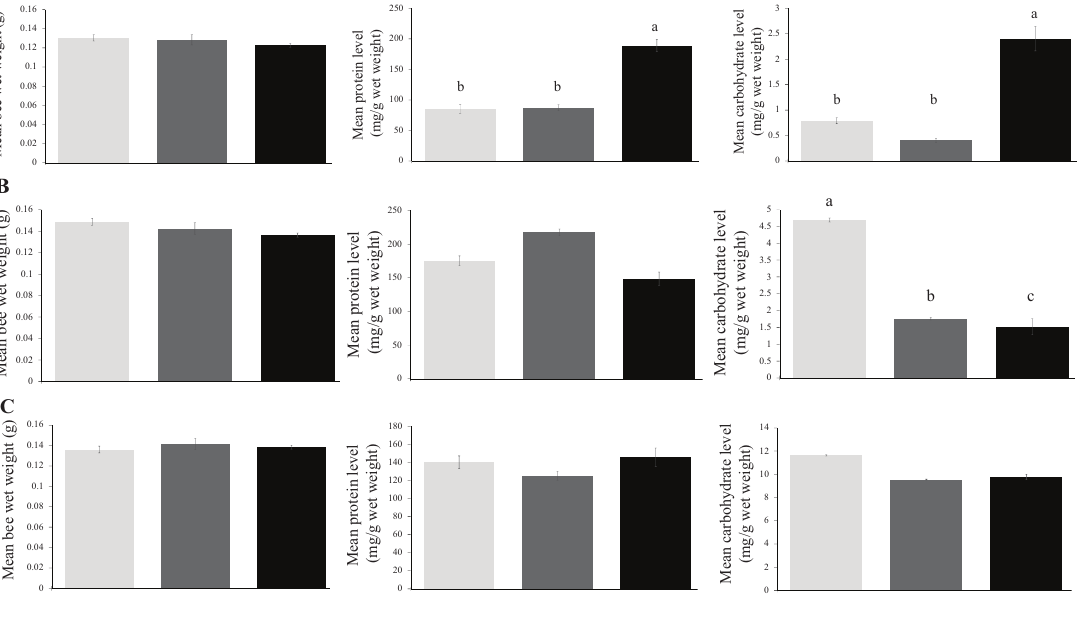
Figure 1. Mean bee wet weight, protein levels, and carbohydrate levels of bees samples from all colonies, regardless of treatment, at three sampling time points during three seasons (fall, spring, and summer). Pesticide treatment had no significant effect on the variables examined, so the data were pooled across the different treatments (three pesticides and control, untreated colonies) for each sampling period within each season ( A ) fall 2012 ( B ) spring 2013 ( C ) summer 2013. Significant differences are indicated by different lowercase letters ( α = 0.05).